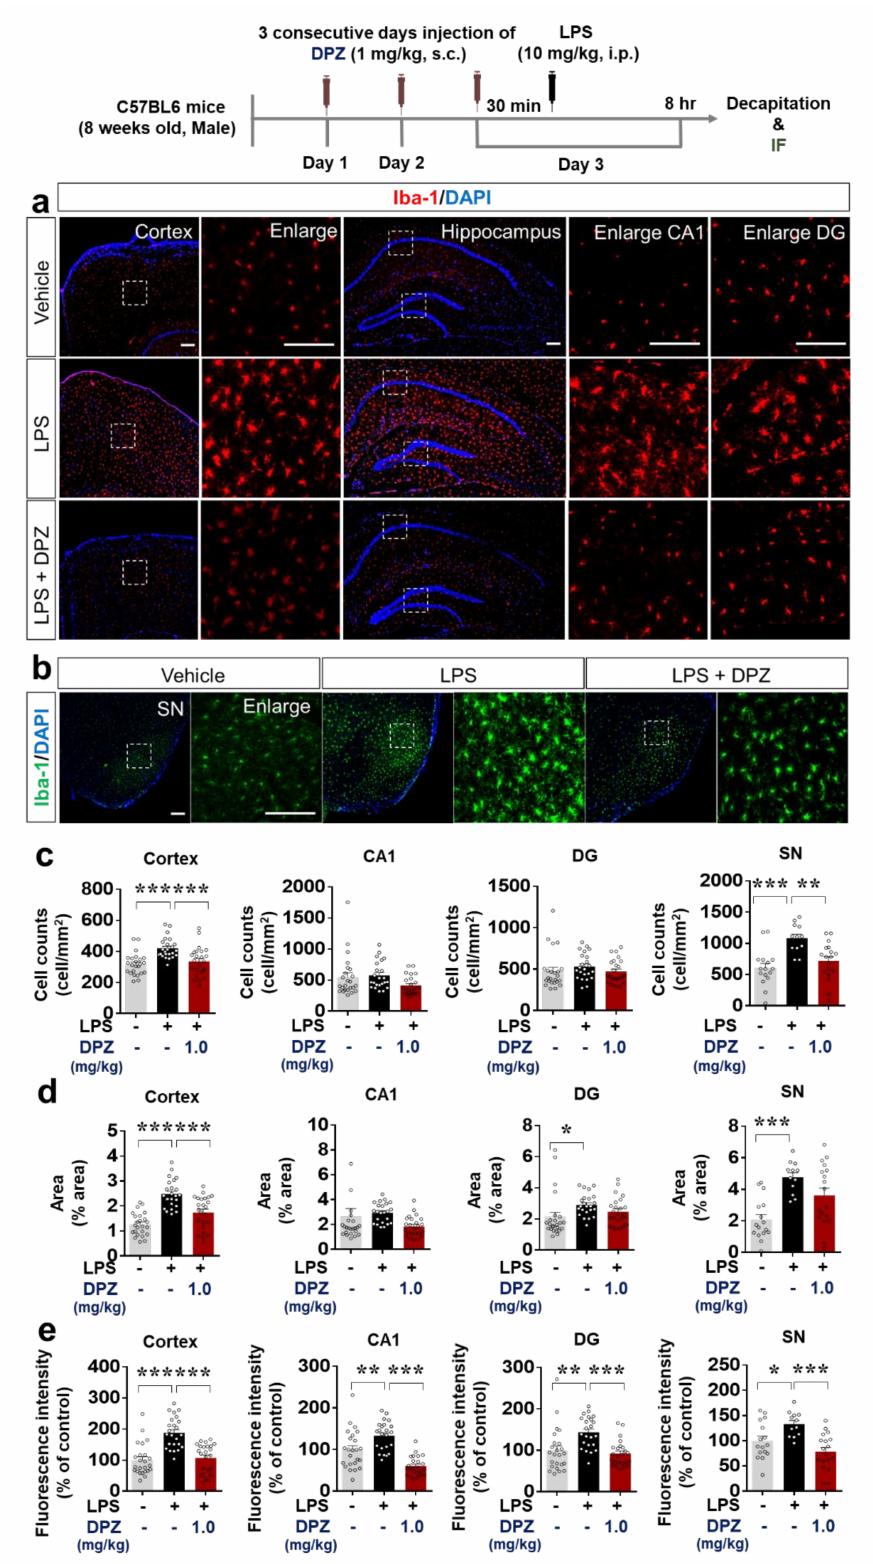
Figure 5. Donepezil suppresses LPS-evoked microgliosis and hypertrophy in wild-type mice. ( a , b ) Iba-1 expression in brain sections from mice treated as shown, as determined by immunostaining with anti-Iba-1. ( c – e ) Quantification of the results in ( a , b ) ( n = 12–24 brain slices from 4 mice/group). * p < 0.05, ** p < 0.01, *** p <